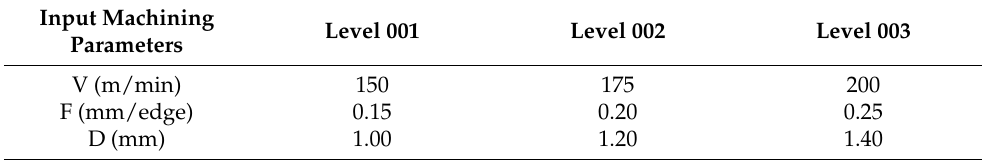
Table 4. Input-machining parameters with their levels.